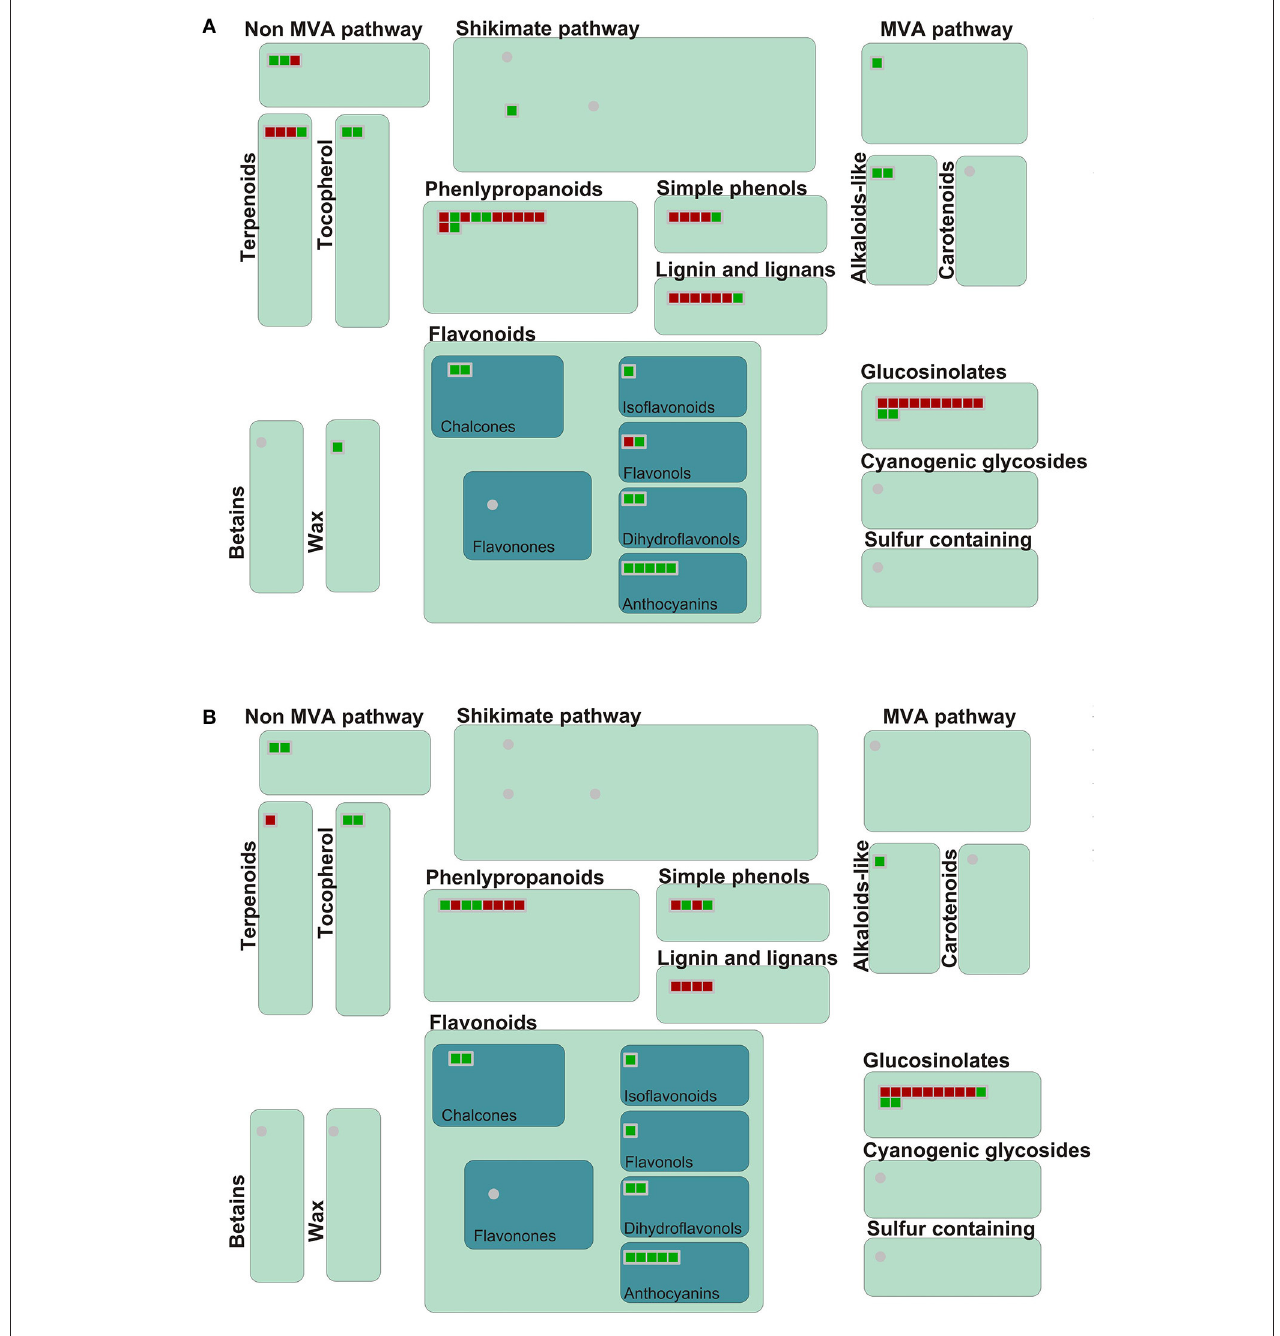
FIGURE 5 | Secondary metabolism pathway analyses of DEGs in A. thaliana during early infection by P. brassicae. Secondary metabolism pathway analysis of the DEGs was performed using MAPMAN software. Red boxes mean up-regulated genes and green mean down-regulated genes. (A) 24 h after inoculation; (B) 48 h after inoculation. The pathway frames are from the MAPMAN software database.